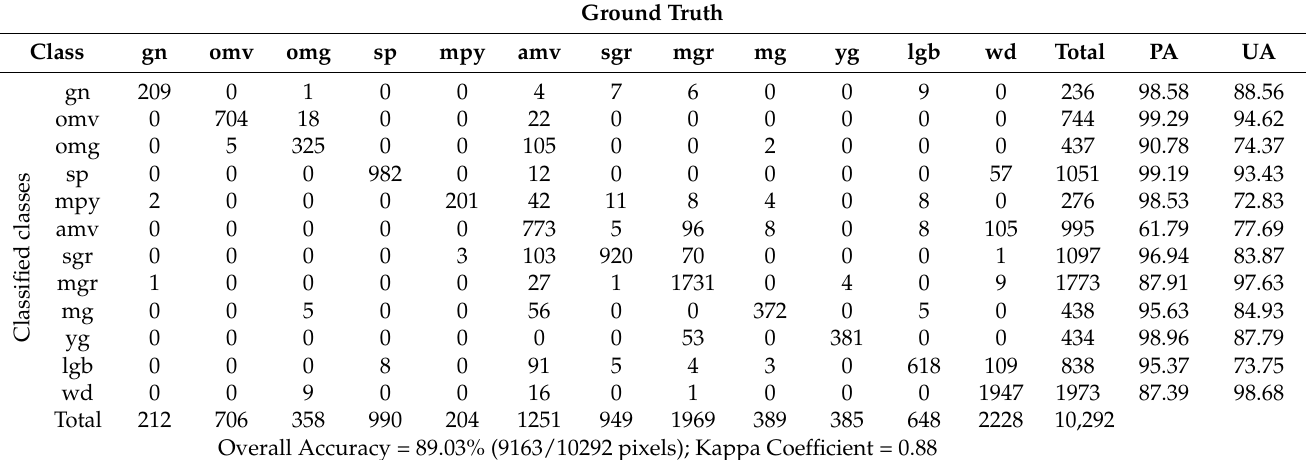
Table 2. The confusion matrix of the Maximum likelihood method. Ground